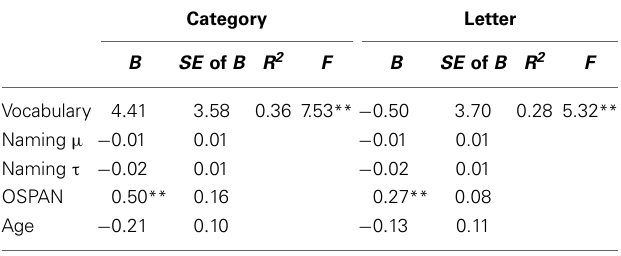
Unstandardized B, Standard Error of B, R 2 and F-Value are listed.